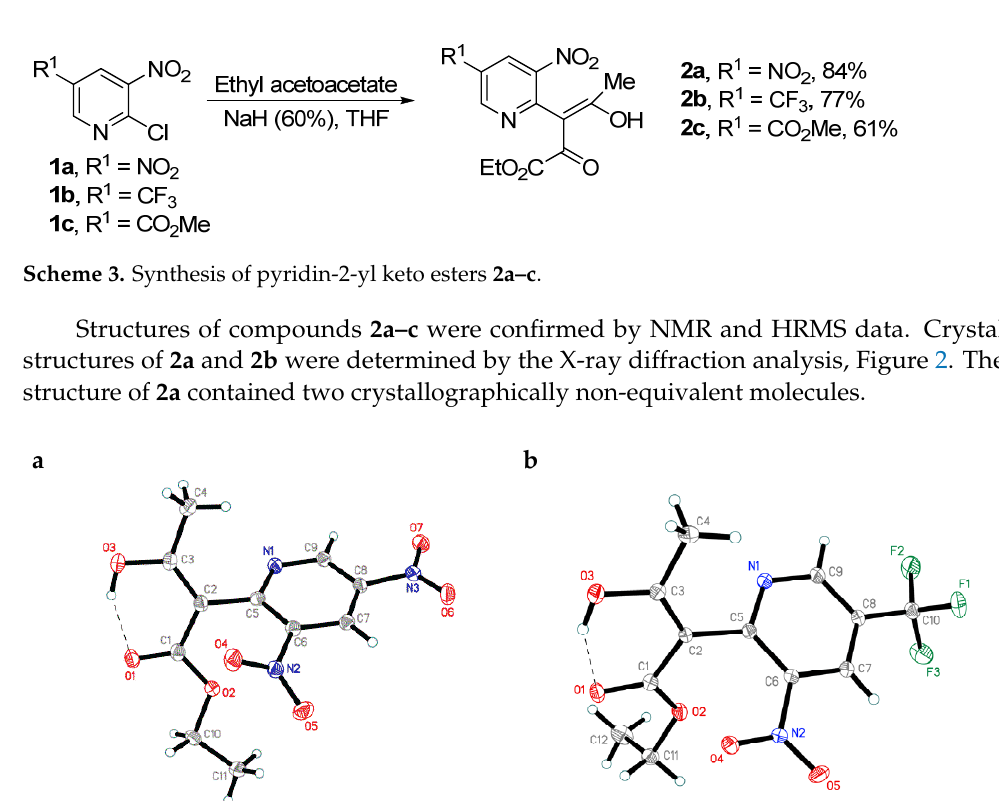
Figure 2. X-ray crystal structures of compounds ( a ) 2a (only one crystallographically unique molecule is shown) and ( b ) 2b with thermal ellipsoids set at a 50% probability level.